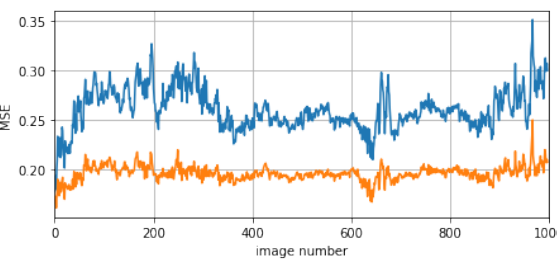
Figure 2. Mean square error between the first and n -th images of unregistered (blue line) and registered (orange line)